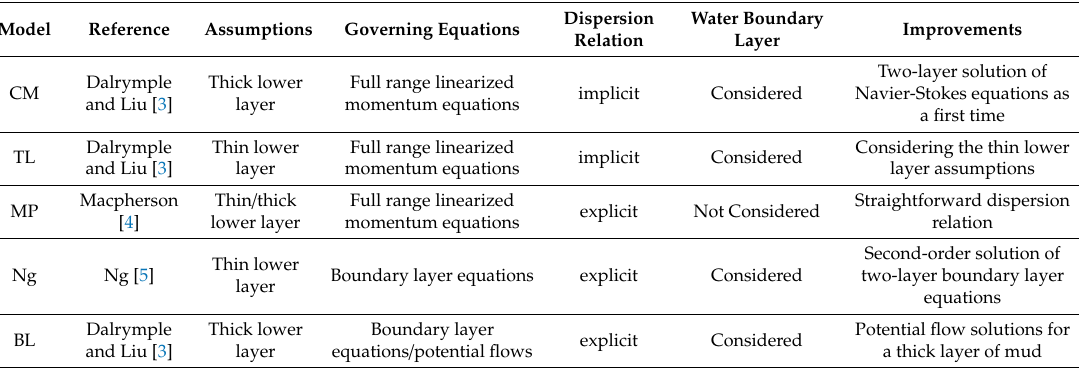
Table 1. List of the models considered in this